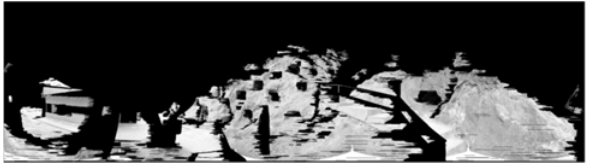
Figure11. The new removal result that the removal process of the circle part was added